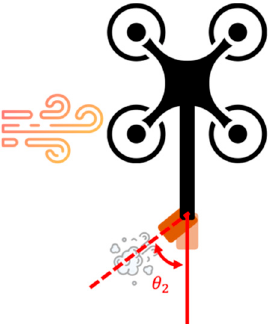
Figure 6. Smoke tube angle correction θ 2 .